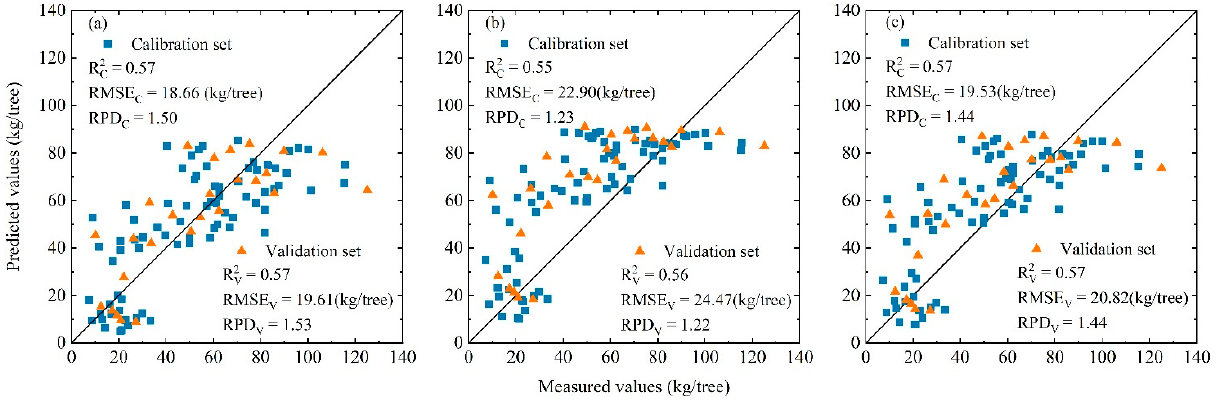
Figure 7. Calibration and validation results of apple yield obtained by the CASA model: ( a ) CASA SR model, ( b ) CASA NDVI model, and ( c ) CASA Average model.